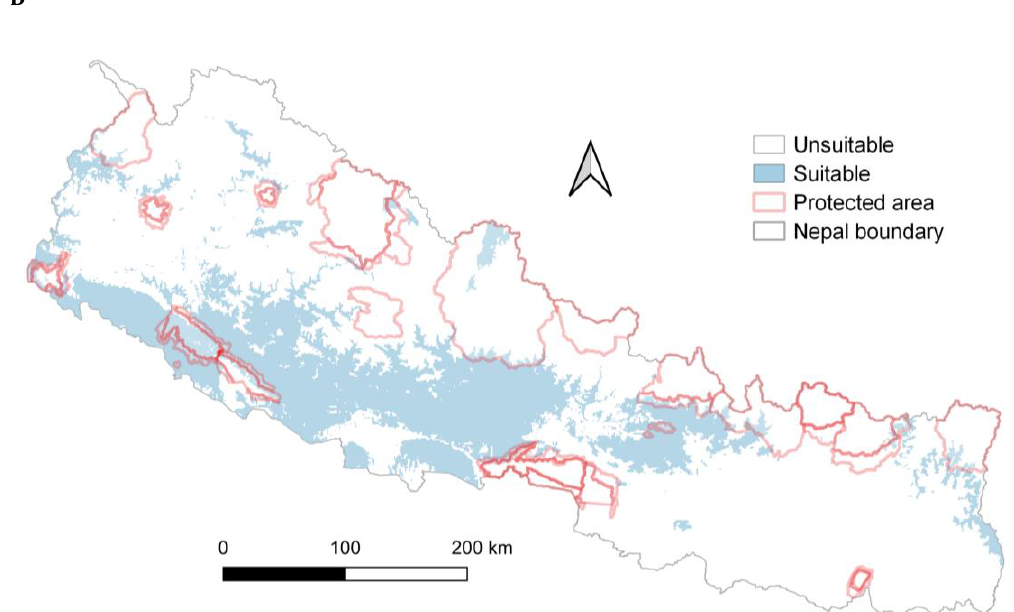
Figure 5. A- Potential suitable nest habitat of Egyptian vultures, Nepal. B- Potential suitable nest 228 habitat of Egyptian vultures and protected areas, Nepal.